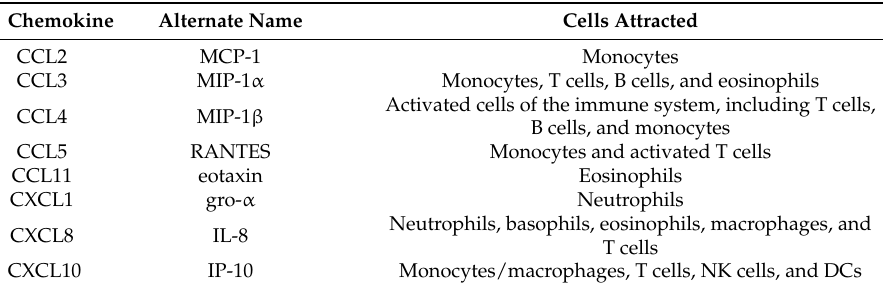
Table 1. Chemokines found in filovirus infection and their